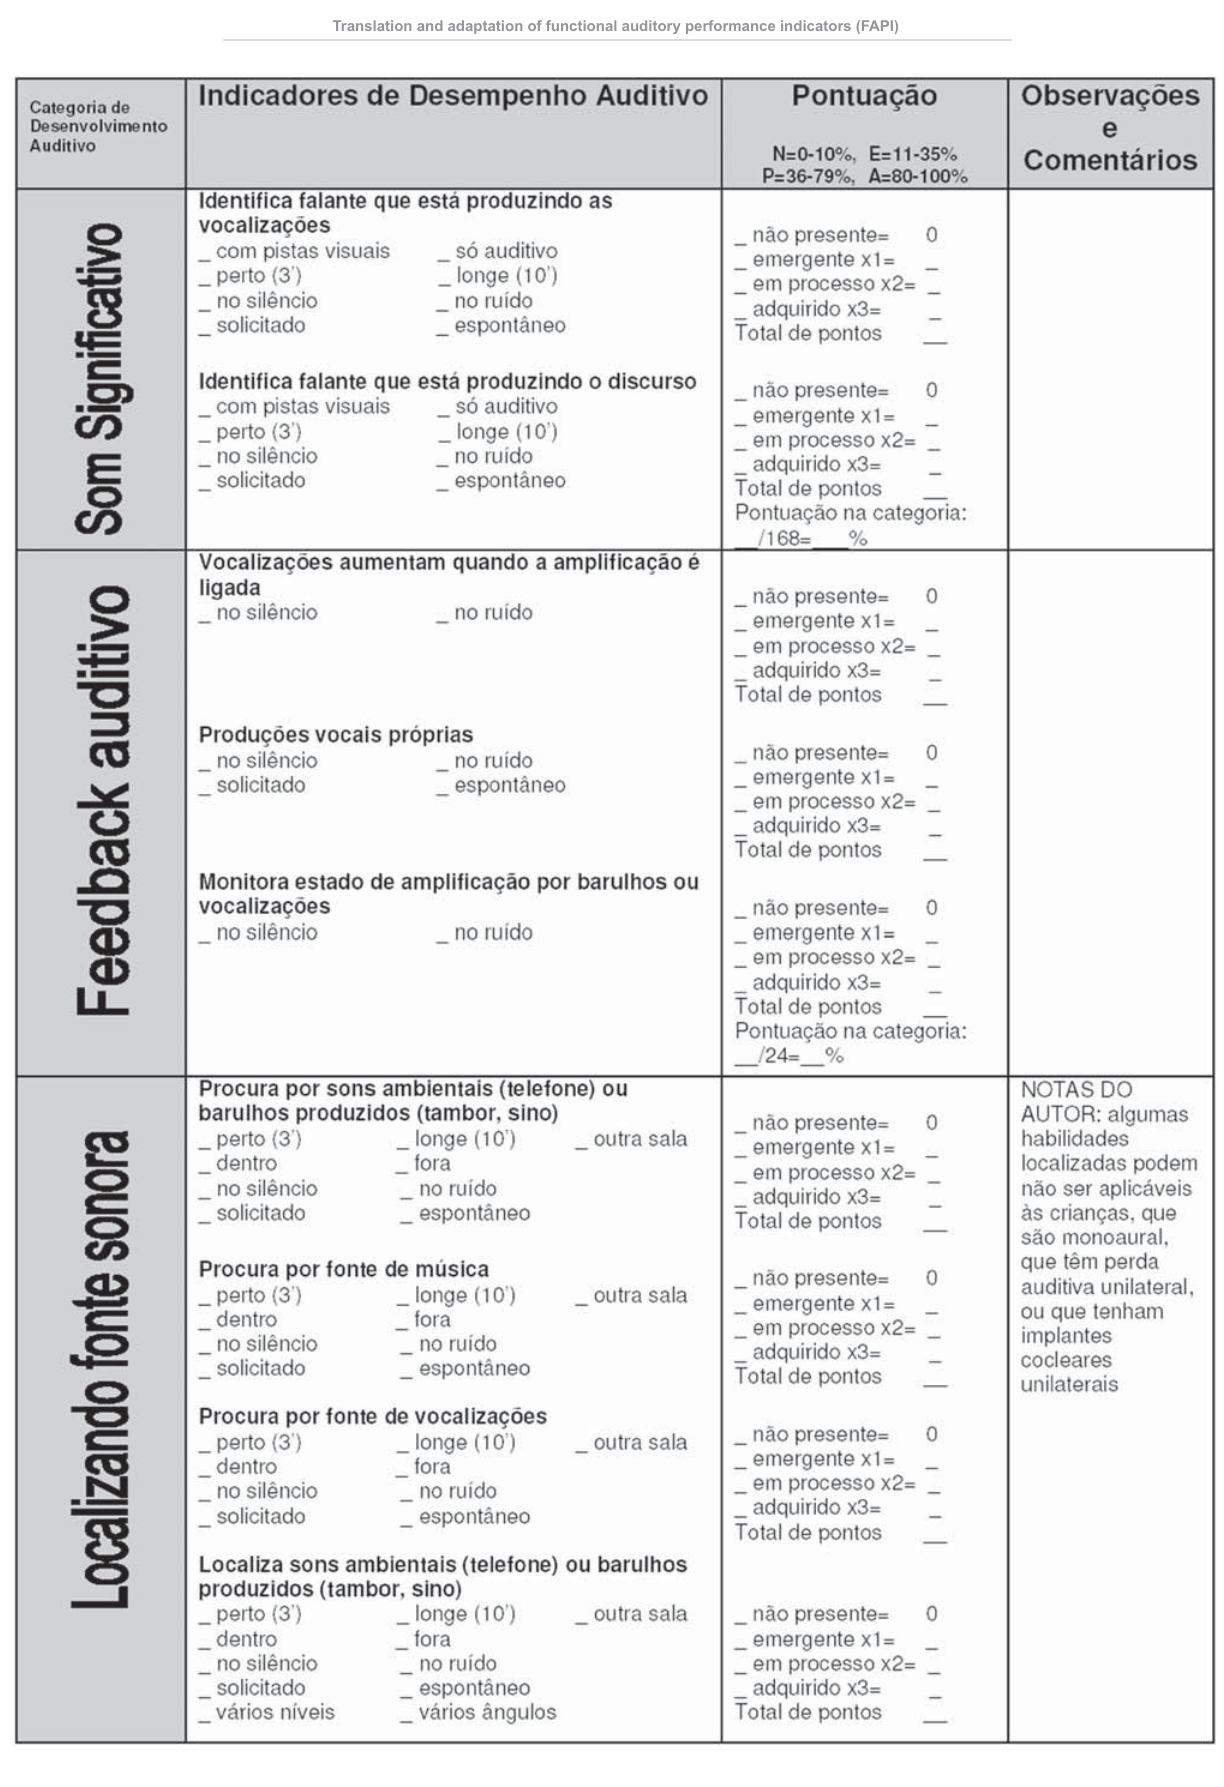
Figures 1B- Final FAPI translation into Portuguese (original in English: Stredler-Brown & Johnson 25